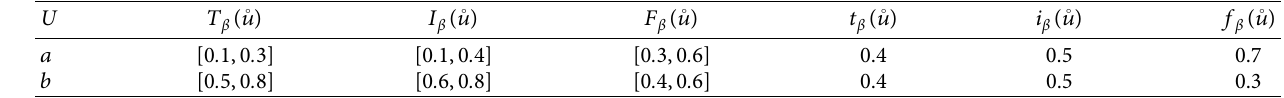
Table 3: Neutrosophic cubic set β of U.